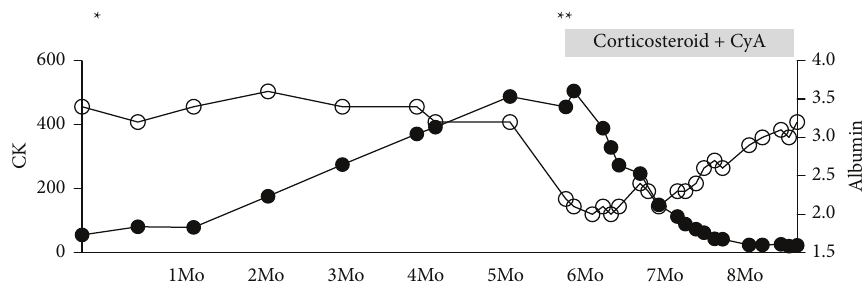
Figure 1: Graph showing serum levels of creatine kinase (CK) and albumin (Alb) over time after discharge from first admission to our hospital. The left vertical axis indicates the serum CK levels ((U/L), closed black circles), and the right axis indicates serum albumin (Alb) levels ((mg/dL), open circles). The horizontal line indicates the months (Mo) after discharge from first admission. ∗ indicates the timing of discharge of first admission to our hospital. ∗∗ indicates readmission to our hospital. CyA: cyclosporine